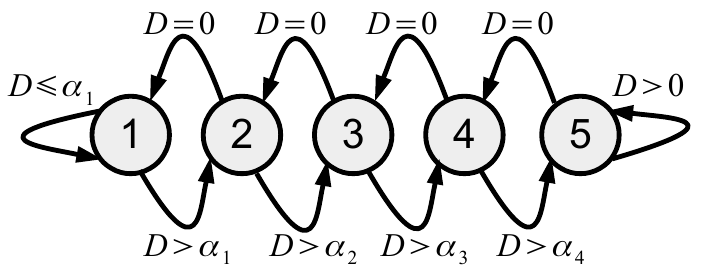
Figure 3. The proposed rate control state